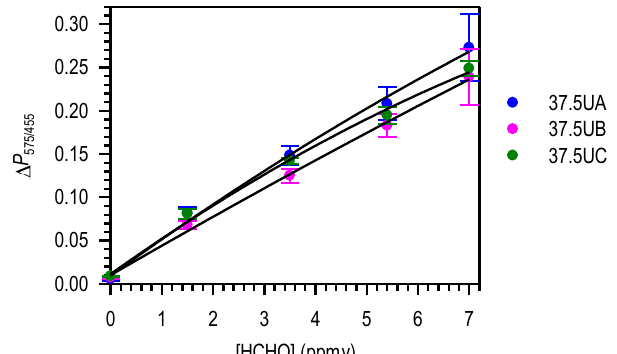
Figure 4. Typical formaldehyde dose-response plot of a sensitive optical fiber in the 1.5–7.0 ppmv range (total flow rate 75 mL min ⁻ 1 , atmospheric pressure, 50% RH, (25 ± 1) °C). The error bars depict the confidence interval (± t s n-1 n ⁻ 1/2 ) for a 95% confidence level ( n = 3). Table 1. Formaldehyde calibration equations, LoD and LoQ obtained from the corresponding dose- response curve for the sensing fibers coded 37.5UA — UC.